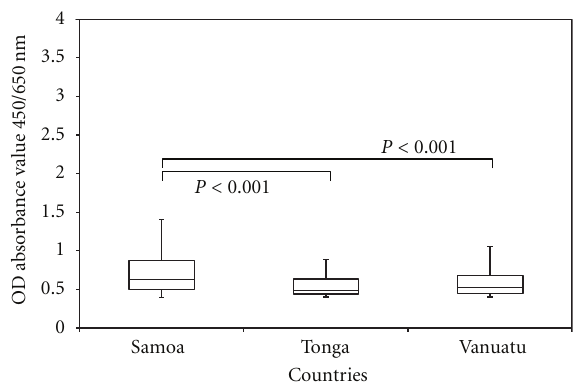
Figure 2: Di ff erences in antibody titre in antibody-positive children residing in Samoa, Tonga, and Vanuatu. Of those children who were antibody positive, there was a significantly higher average antibody titre in Samoa than Vanuatu and Tonga ( χ 2 = 41; df = 2; P = 0).